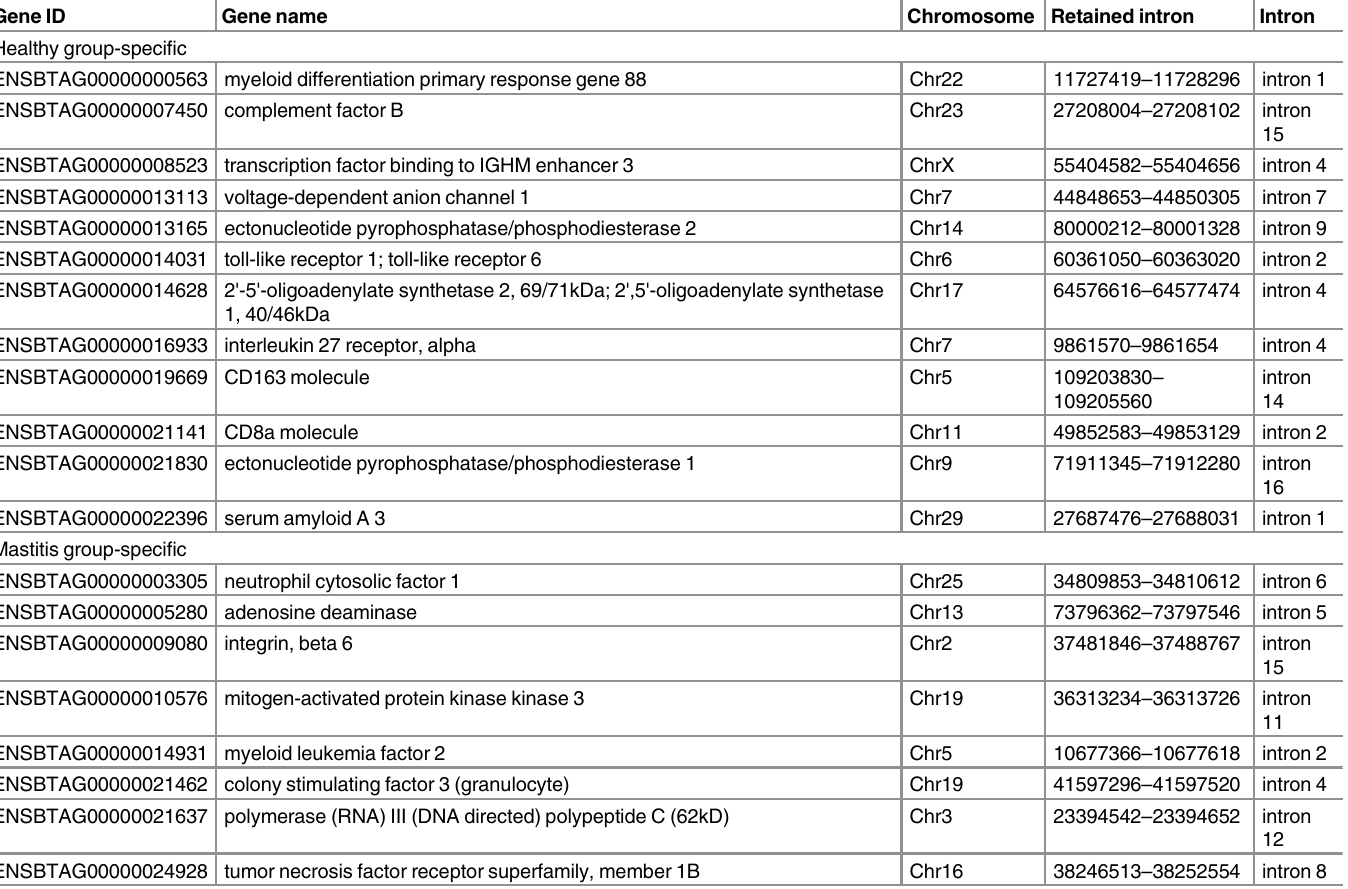
Table 2. Genes with retained intron events were health-specific and mastitis-specific and participated in immune, defense and inflammatory